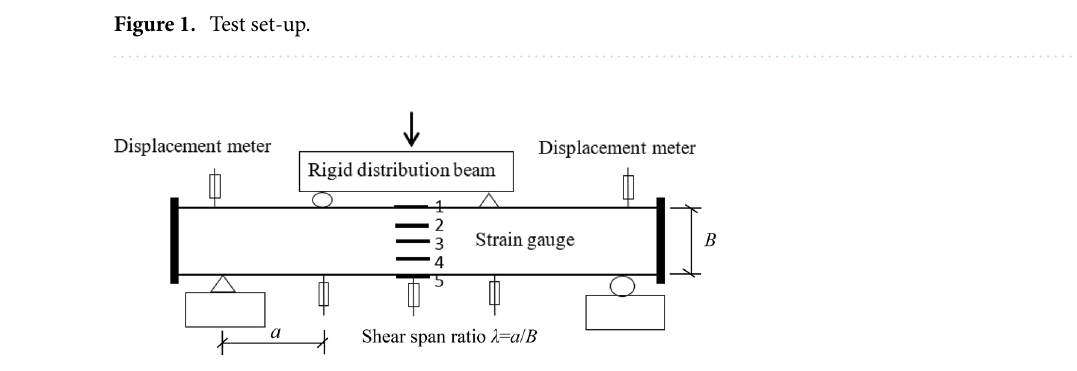
Figure 2. Schematic diagram of measuring